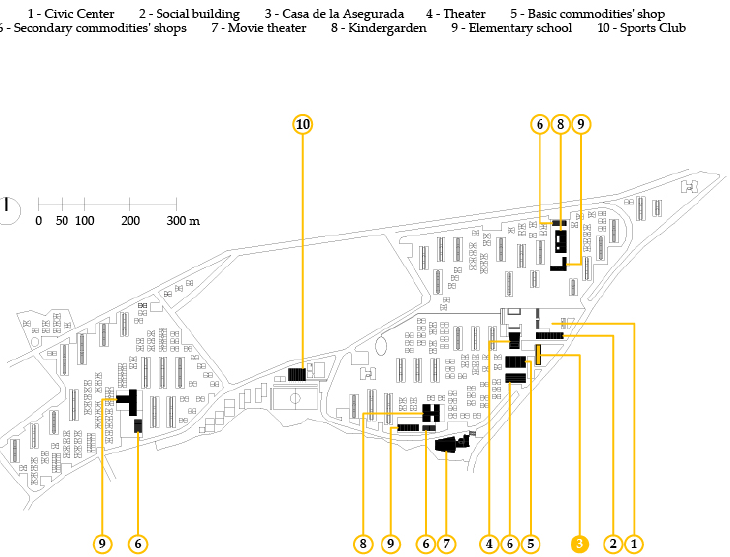
Figure 7. General layout of the Unidad Independencia housing complex with the location of its facilities. Source: own creation, 2021.